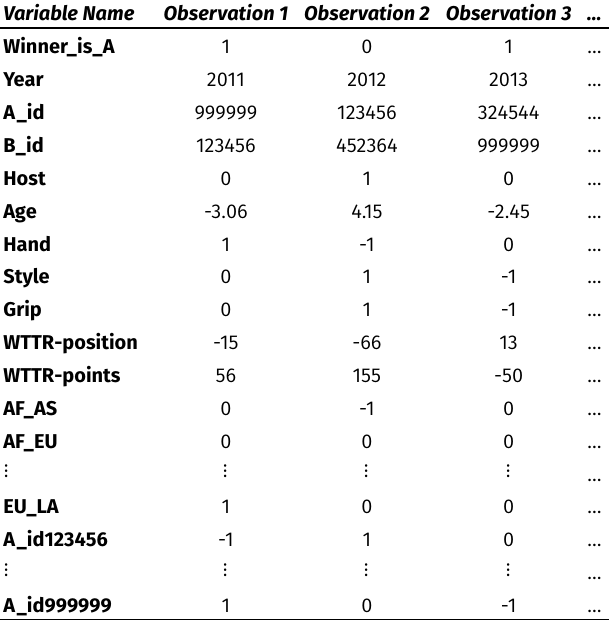
Table 2. Overview of the used data set. Note: Shown is artificial data to give an impression of the value ranges. Each column represents a match and each row a variable.